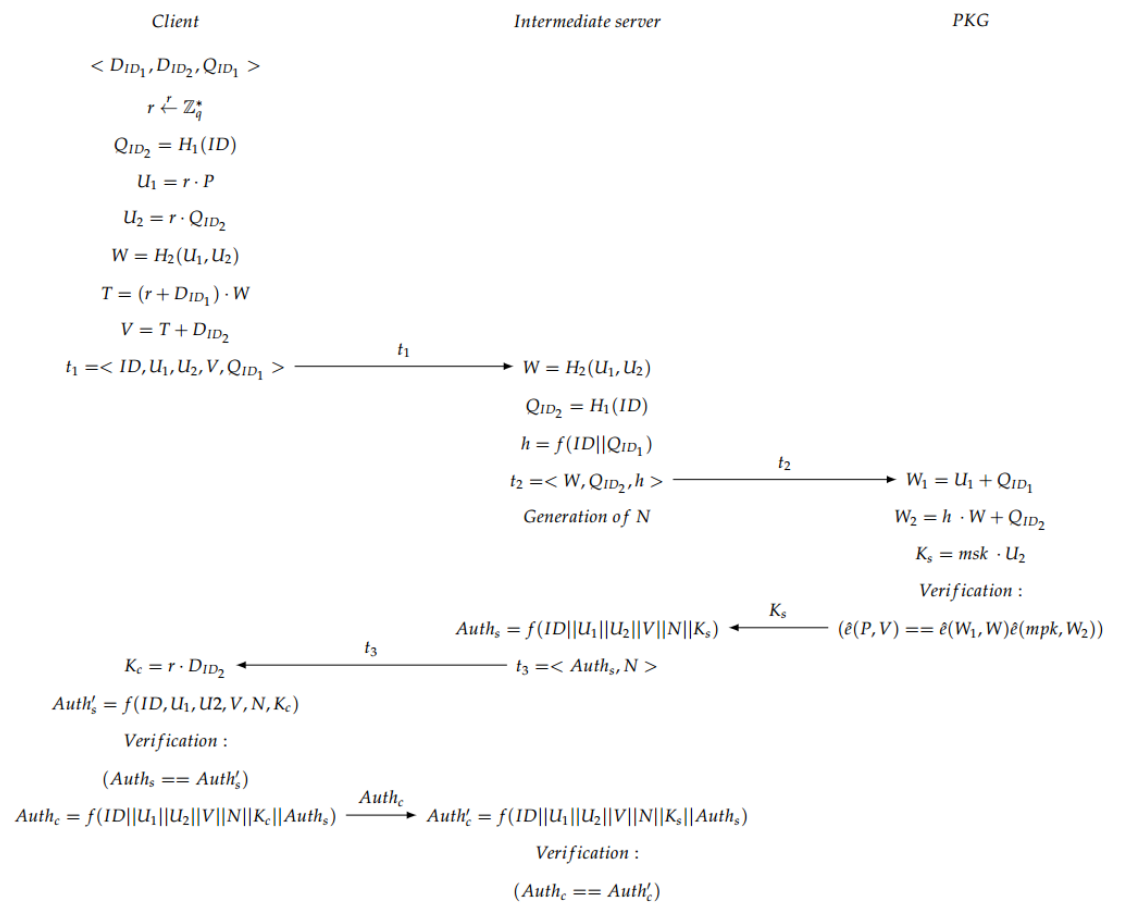
Figure 6. Mutual authentication phase.